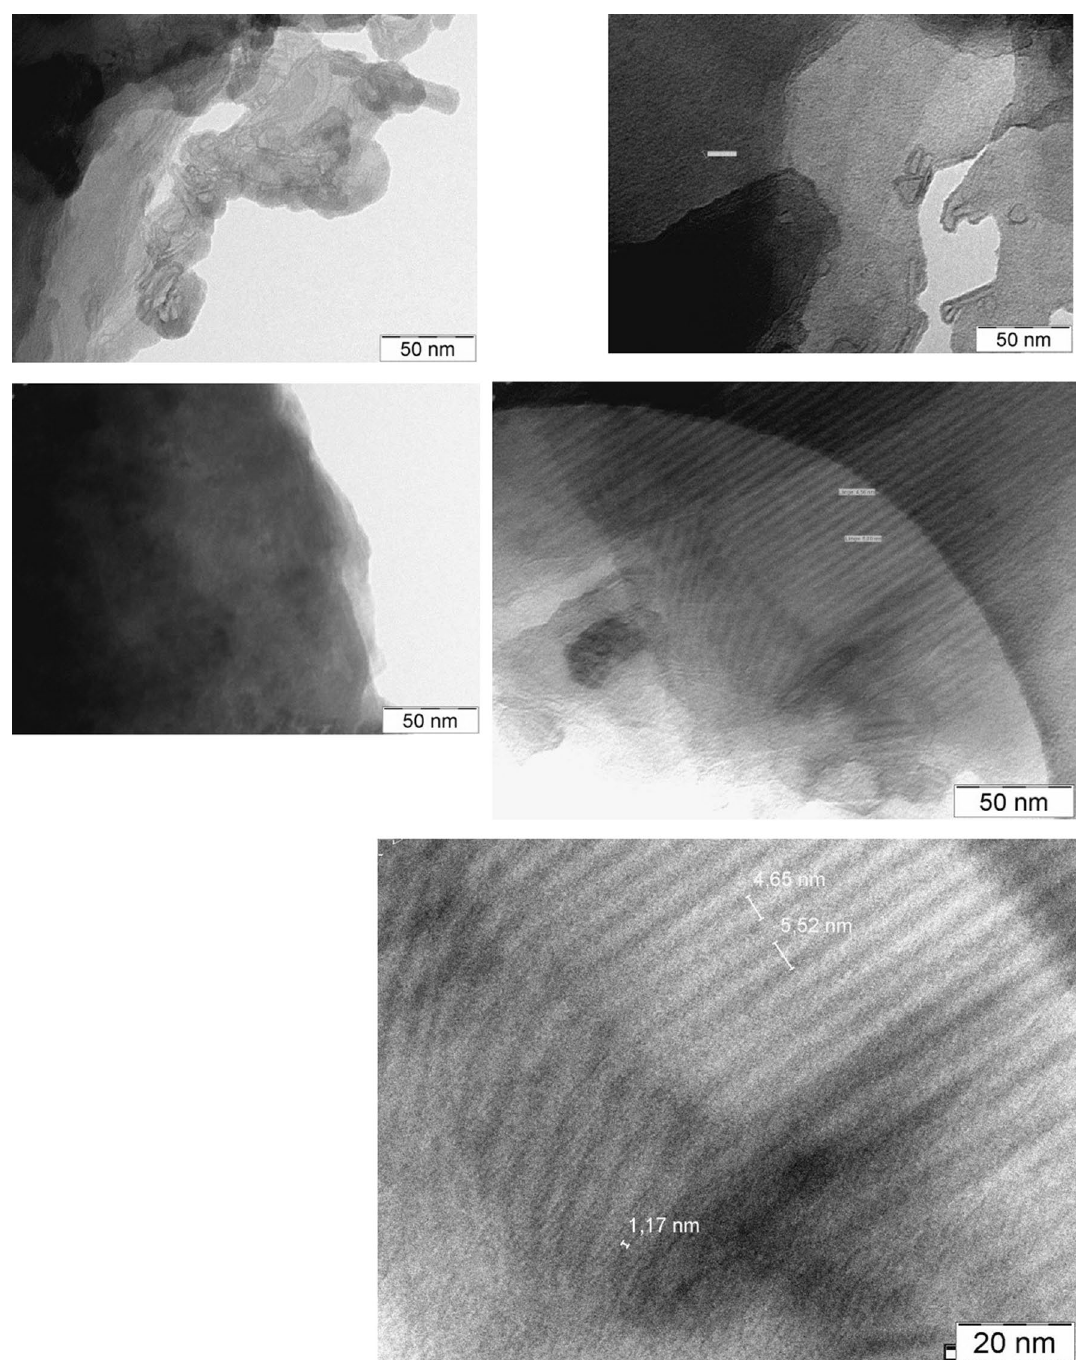
Figure 3. TEM images of: dl–ld (left) and dd–ll